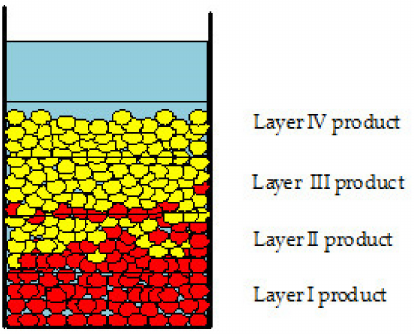
Figure 1. A scheme of investigations for testing the regular and irregular particles in the particle size fraction 6.3–8.0 mm in a laboratory ring jig device.